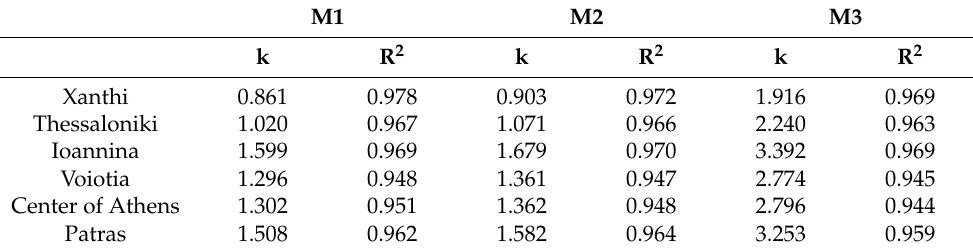
Table 12. k coefficient (mm/day 1/2 ) and coefficient of determination R 2 of cement mortars exposed in the selected areas. M1 M2